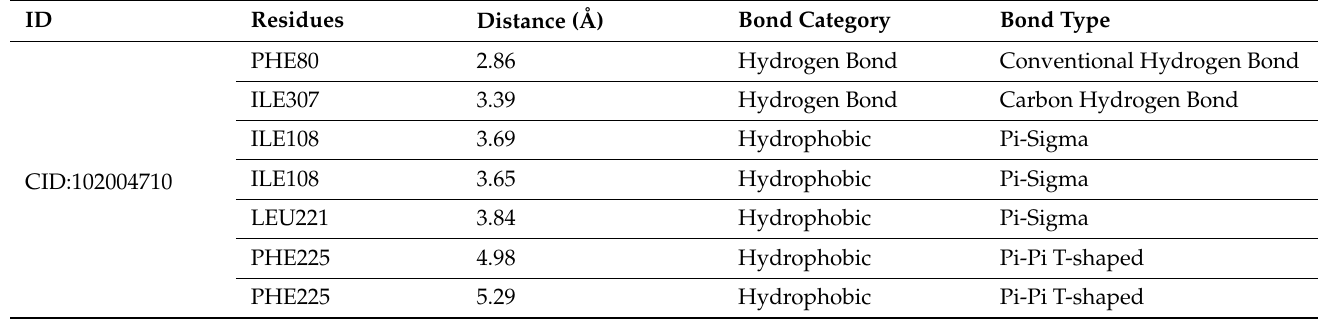
Figure 6. Interaction between the compound CID: 5281349 and thymidylate synthase. The left side represents 3D, and the right side represents 2D complex interaction. Table 4. List of binding interactions between four selected phytochemicals with thymidylate